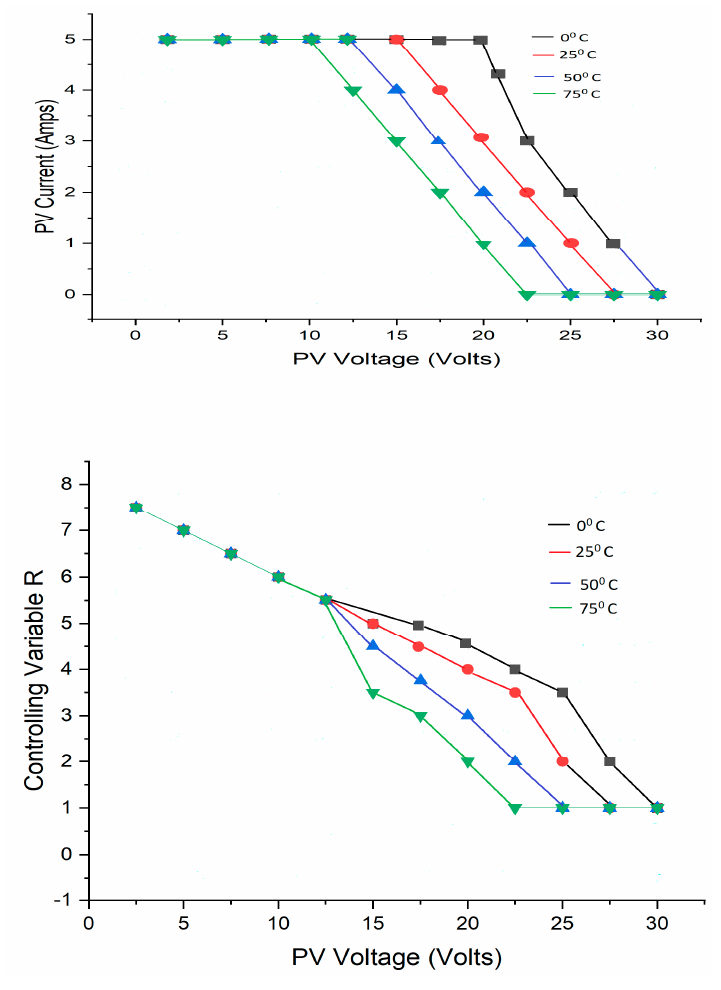
Figure 3. V-I and V-R characteristics for different PV temperature.